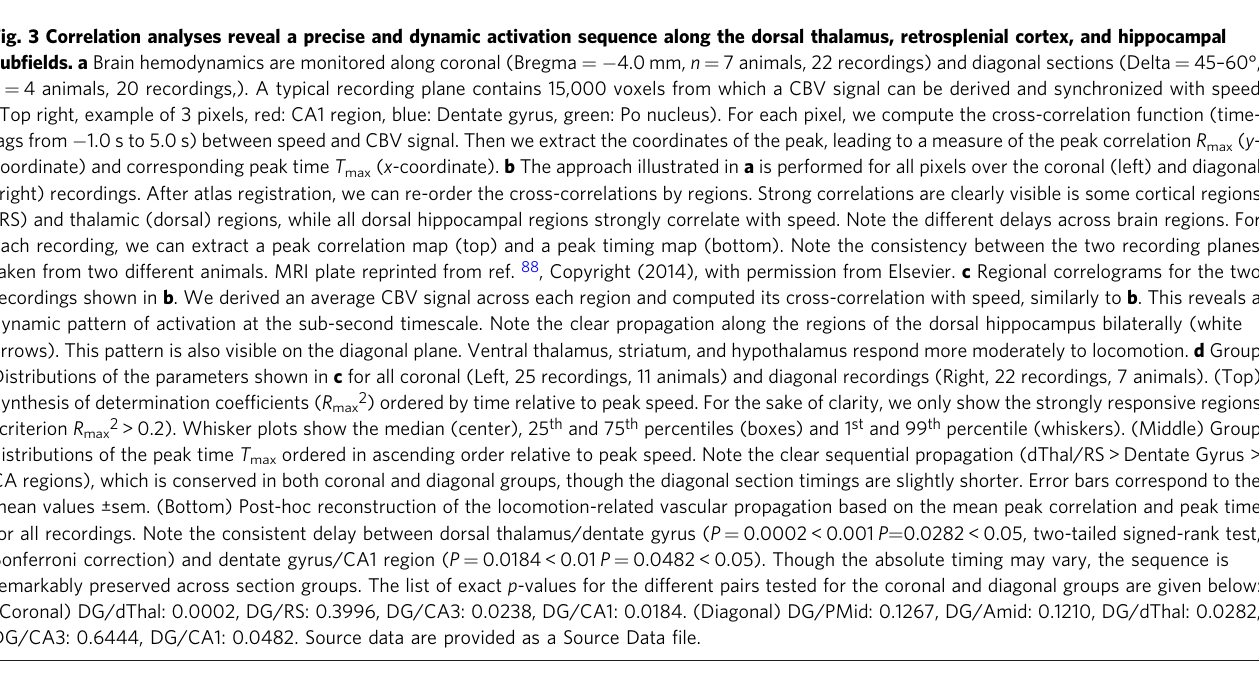
Fig. 3 Correlation analyses reveal a precise and dynamic activation sequence along the dorsal thalamus, retrosplenial cortex, and hippocampal sub fi elds. a Brain hemodynamics are monitored along coronal (Bregma = − 4.0 mm, n = 7 animals, 22 recordings) and diagonal sections (Delta = 45 – 60°, n = 4 animals, 20 recordings,). A typical recording plane contains 15,000 voxels from which a CBV signal can be derived and synchronized with speed (Top right, example of 3 pixels, red: CA1 region, blue: Dentate gyrus, green: Po nucleus). For each pixel, we compute the cross-correlation function (time- lags from − 1.0 s to 5.0 s) between speed and CBV signal. Then we extract the coordinates of the peak, leading to a measure of the peak correlation R max ( y - coordinate) and corresponding peak time T max ( x -coordinate). b The approach illustrated in a is performed for all pixels over the coronal (left) and diagonal (right) recordings. After atlas registration, we can re-order the cross-correlations by regions. Strong correlations are clearly visible is some cortical regions (RS) and thalamic (dorsal) regions, while all dorsal hippocampal regions strongly correlate with speed. Note the different delays across brain regions. For each recording, we can extract a peak correlation map (top) and a peak timing map (bottom). Note the consistency between the two recording planes taken from two different animals. MRI plate reprinted from ref. 88 , Copyright (2014), with permission from Elsevier. c Regional correlograms for the two recordings shown in b . We derived an average CBV signal across each region and computed its cross-correlation with speed, similarly to b . This reveals a dynamic pattern of activation at the sub-second timescale. Note the clear propagation along the regions of the dorsal hippocampus bilaterally (white arrows). This pattern is also visible on the diagonal plane. Ventral thalamus, striatum, and hypothalamus respond more moderately to locomotion. d Group Distributions of the parameters shown in c for all coronal (Left, 25 recordings, 11 animals) and diagonal recordings (Right, 22 recordings, 7 animals). (Top) Synthesis of determination coef fi cients ( R max 2 ) ordered by time relative to peak speed. For the sake of clarity, we only show the strongly responsive regions (criterion R max 2 > 0.2). Whisker plots show the median (center), 25 th and 75 th percentiles (boxes) and 1 st and 99 th percentile (whiskers). (Middle) Group distributions of the peak time T max ordered in ascending order relative to peak speed. Note the clear sequential propagation (dThal/RS > Dentate Gyrus > CA regions), which is conserved in both coronal and diagonal groups, though the diagonal section timings are slightly shorter. Error bars correspond to the mean values ±sem. (Bottom) Post-hoc reconstruction of the locomotion-related vascular propagation based on the mean peak correlation and peak time for all recordings. Note the consistent delay between dorsal thalamus/dentate gyrus ( P = 0.0002 < 0.001 P = 0.0282 < 0.05, two-tailed signed-rank test, Bonferroni correction) and dentate gyrus/CA1 region ( P = 0.0184 < 0.01 P = 0.0482 < 0.05). Though the absolute timing may vary, the sequence is remarkably preserved across section groups. The list of exact p -values for the different pairs tested for the coronal and diagonal groups are given below: (Coronal) DG/dThal: 0.0002, DG/RS: 0.3996, DG/CA3: 0.0238, DG/CA1: 0.0184. (Diagonal) DG/PMid: 0.1267, DG/Amid: 0.1210, DG/dThal: